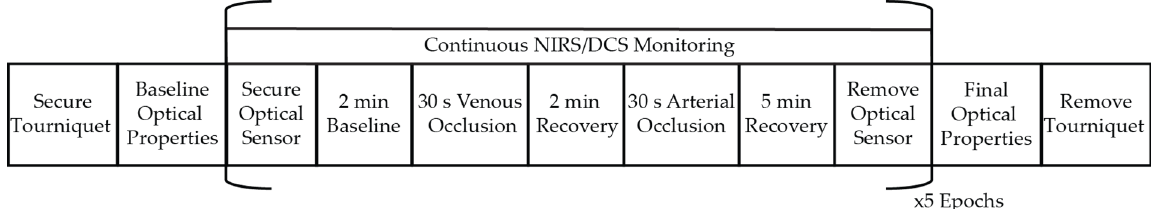
Figure 4. Experimental protocol. First, a tourniquet was secured to the thigh. Participants sat with their leg relaxed to limit hyperextension/enforced extension of the knee. Baseline resting-state optical properties were measured with NIRS by manually holding an optical sensor over the medial gastrocnemius (MG) muscle. Next, the optical sensor was secured to the MG for continuous NIRS/DCS monitoring throughout serial venous and arterial occlusions. This occlusion protocol was repeated 5 times, repositioning the sensor in between each epoch. Upon completion of 5 epochs, a final measure of resting-state optical properties with NIRS was made.